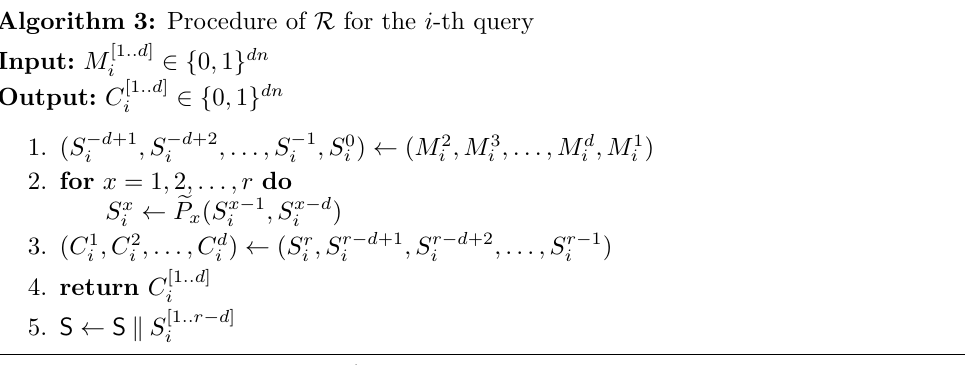
Algorithm 4: Procedure of R − 1 for the i -th query